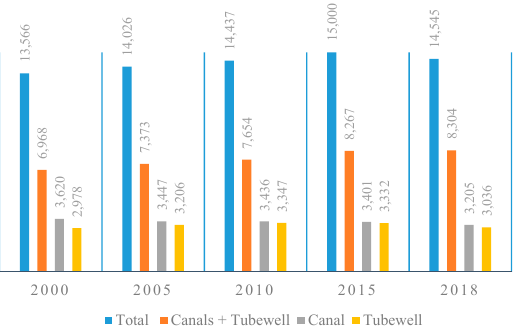
Figure 6. Area irrigated (‘000’ ha) by different modes of irrigation in the Punjab province (Source: Punjab Irrigation Department).